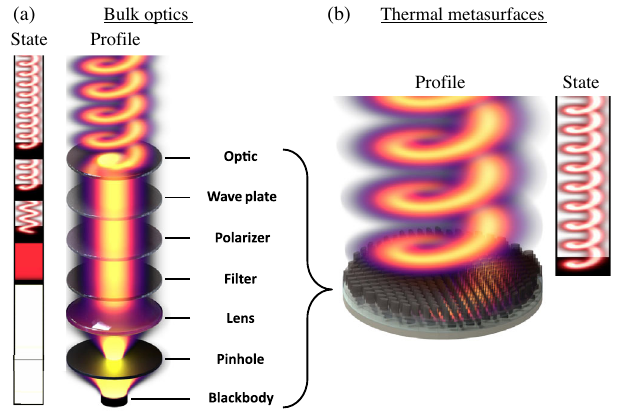
FIG. 1. Comparison of conventional optics and thermal meta- surfaces producing light with desired SAM and OAM. (a) In the bulk optics approach, the emission from a blackbody is spatially filtered, collimated, spectrally filtered, polarized, retarded, and shaped by separate components, leading to large inefficiencies and bulky setups. (b) With a thermal metasurface, thermal emission is shaped at the source by a subwavelength